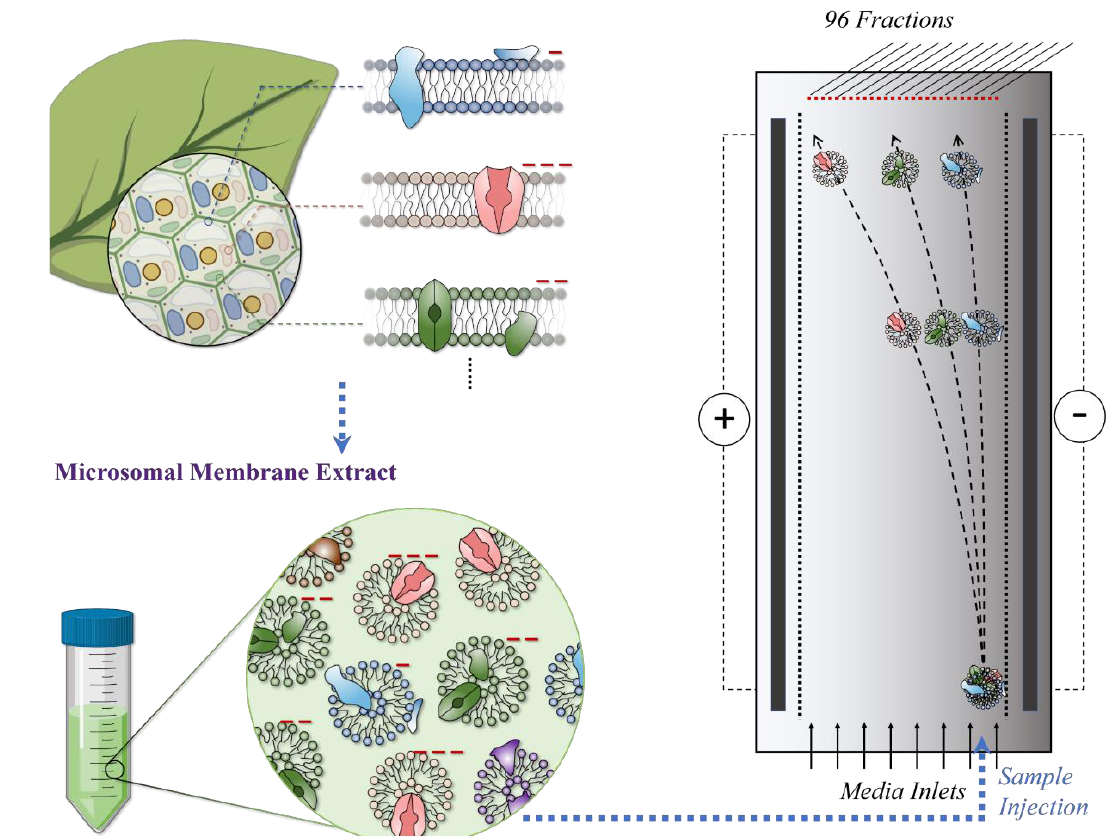
Figure 1. Schematic diagram of the working principle of Free Flow Electrophoresis (FFE) for plant subcellular membrane fractionation. Subcellular membranes with different origins (organelle/subcellular compartment) possess different overall surface charges mainly due to the chemical and compositional diversity of membrane lipids and proteins. In general, membranes exhibit negative surface charges around a neutral pH. Subcellular membranes form vesicles during the microsomal extraction procedure as described in “Materials and Methods”. Microsomal membranes are injected into the chamber and subjected to a high-voltage electric field. Membranes separate according to their distinct surface charge.